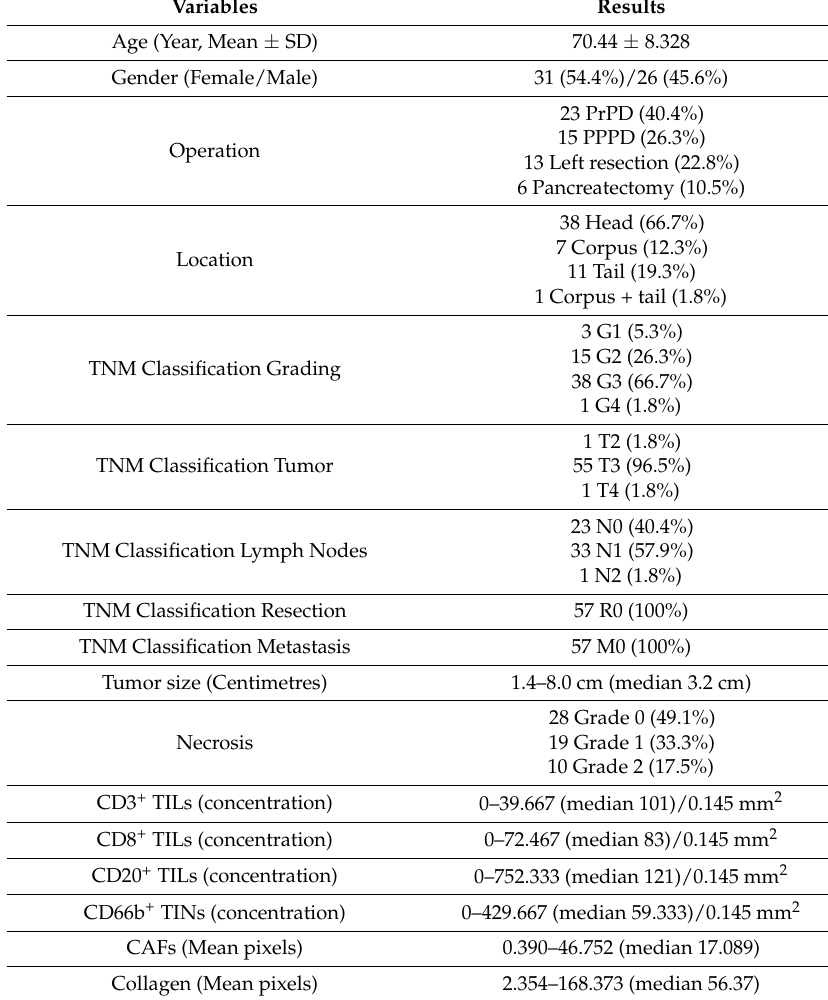
Table 1. Demographics of the study